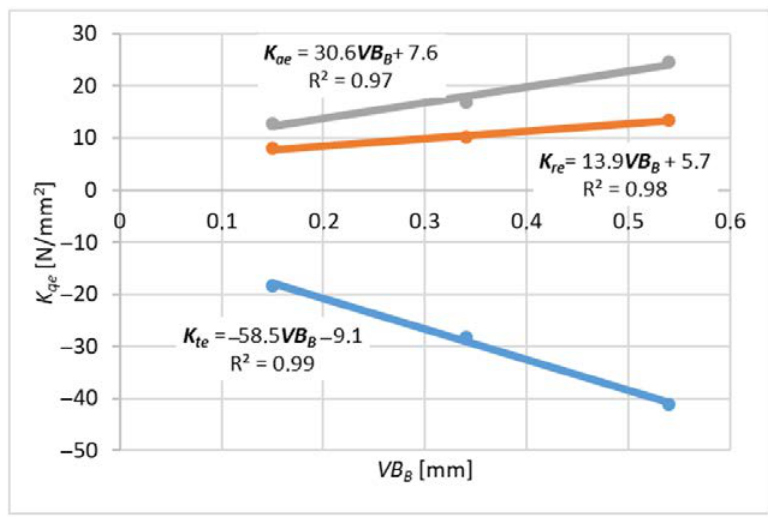
Figure 12. The influence of wear on the coefficient of cutting forces K e for slot-milling.